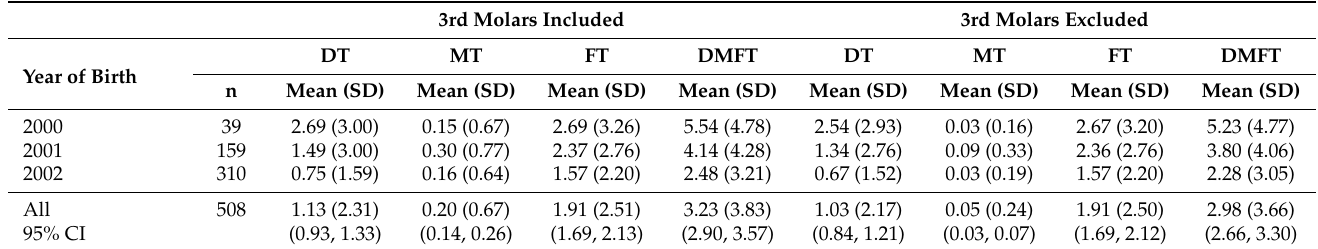
Table 2. DMFT values with and without third molars.